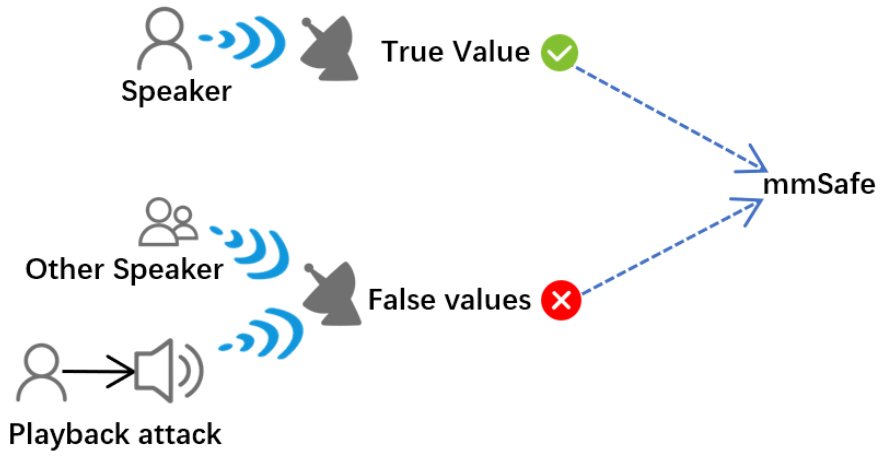
Figure 6. Significance of experimental data.